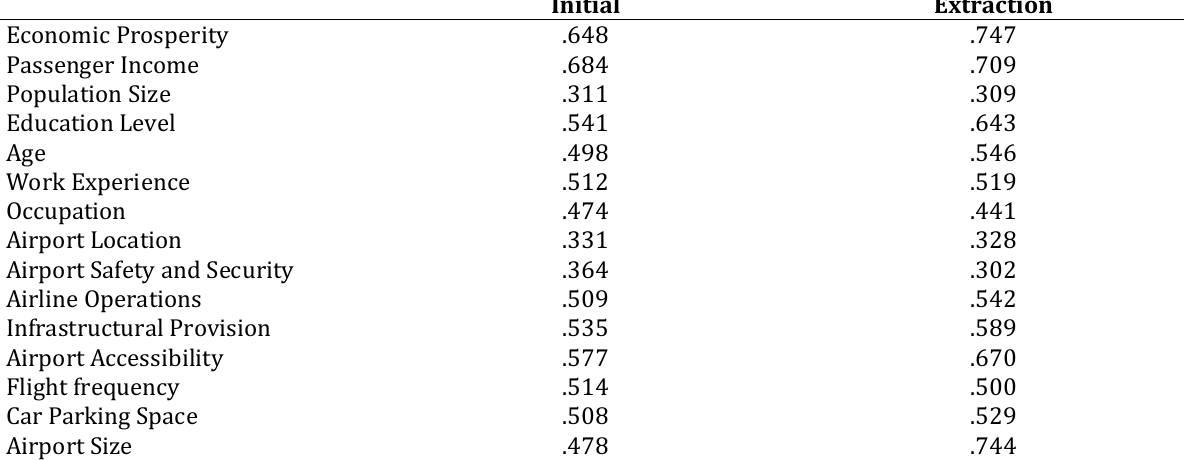
Table 8: Communalities of factors influencing passenger traffic at domestic airports Initial